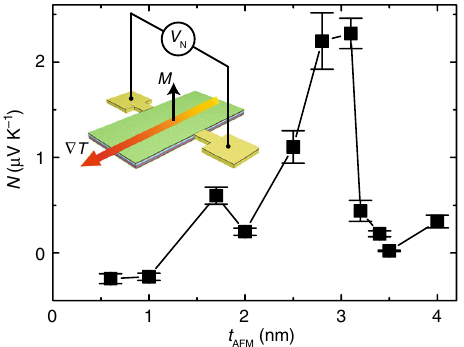
Fig. 6 Anomalous Nernst effect. The anomalous Nernst coef fi cients measured as a function of the IrMn thickness at room temperature. The error bars indicate the signal-to-noise level of the anomalous Nernst measurements. The inset illustrates the anomalous Nernst effect with Nernst voltage V N measured normal to temperature gradient ∇ T with perpendicular magnetization M . The error bars are extracted from the results difference of measurements which were repeated